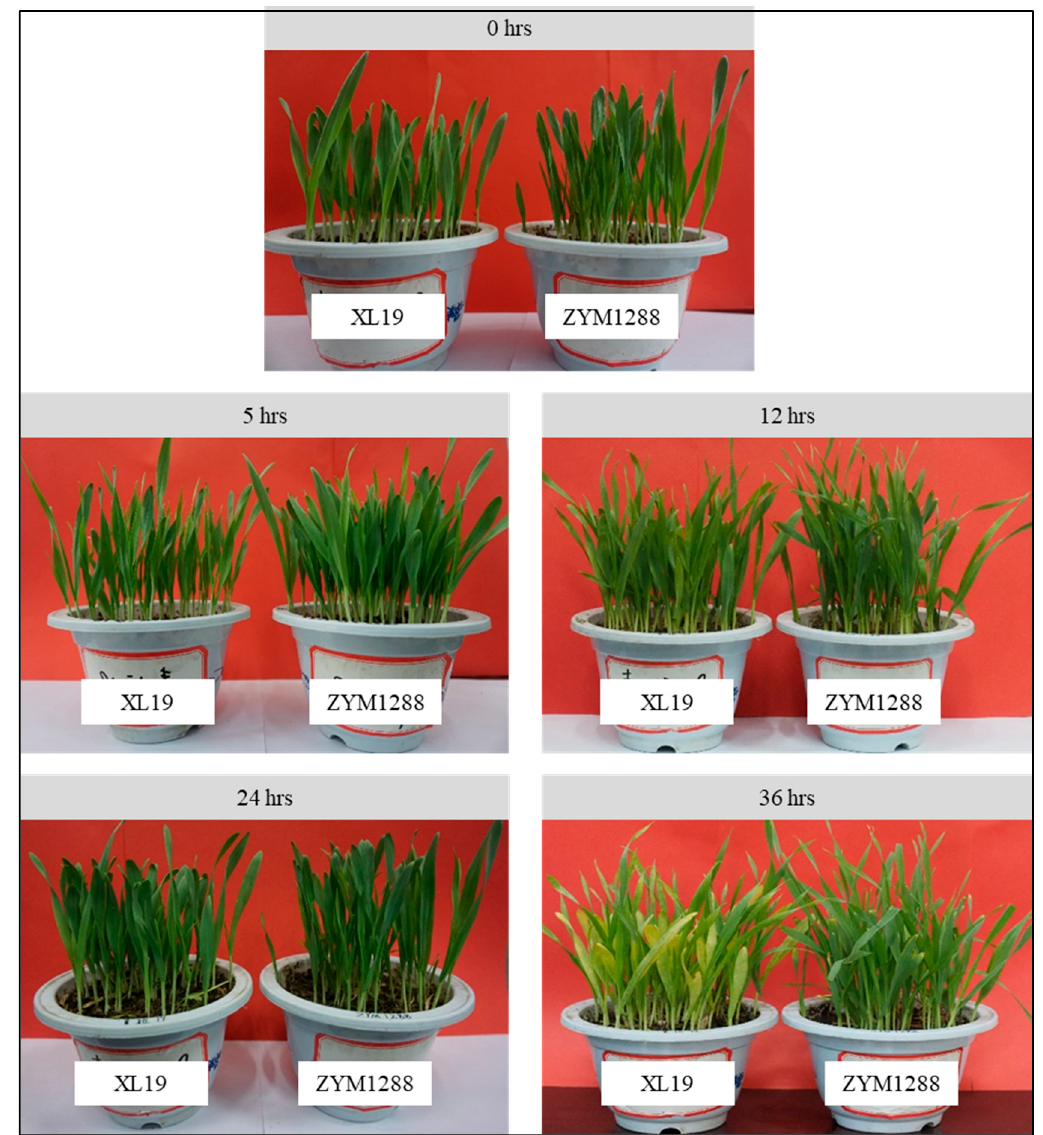
Figure 1. XL19 and ZYM1288 hulless barley genotypes infected with Bgh after 0 (CK), 5, 12, 24, and 36 h.